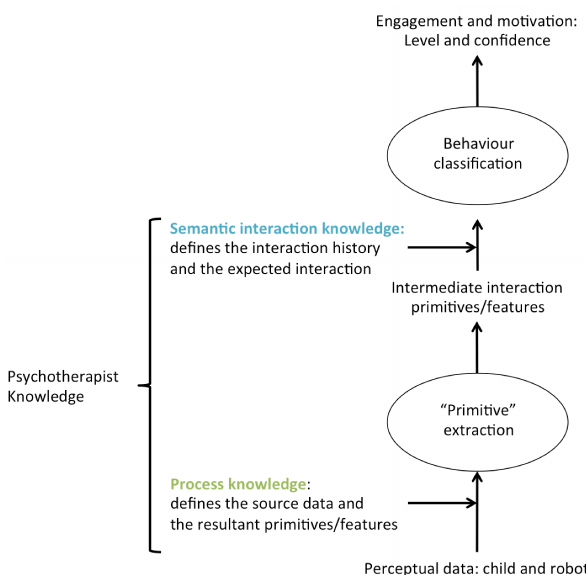
Figure 9: Child behaviour analysis flow.